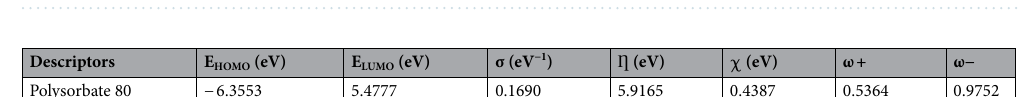
Figure 3. Optimized structures, HOMO & LUMO, and ESP maps for polysorbate 80 molecule in aqueous phase.